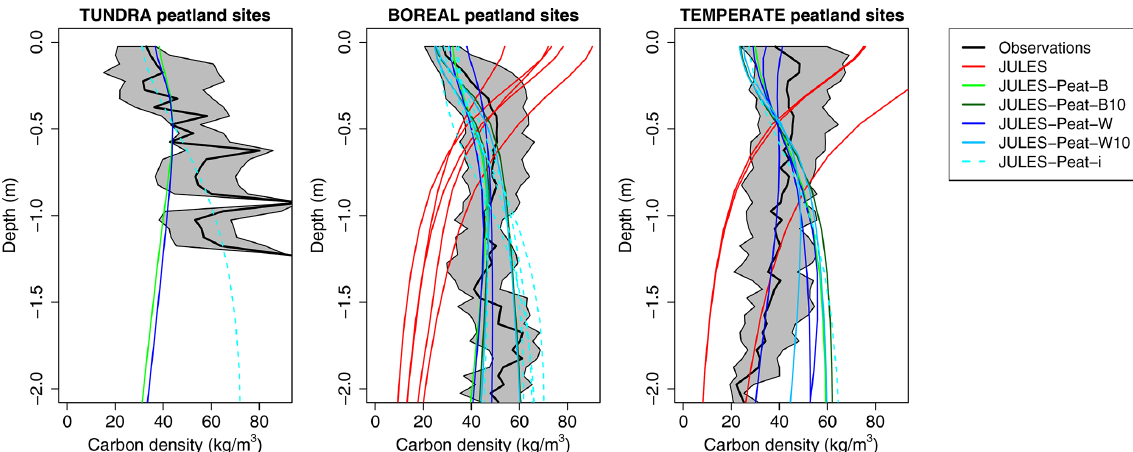
Figure 5. Evaluation of JULES-Peat carbon profile against the median profile from peat cores. The grey-shaded area shows the interquartile range. Only sites where the model simulates a sufficiently thick organic layer to classify it as peat ( > 15% carbon by mass for ≥ 39cm; see Sect. 3) are shown. The sites that are shown for each simulation are highlighted in bold in Table